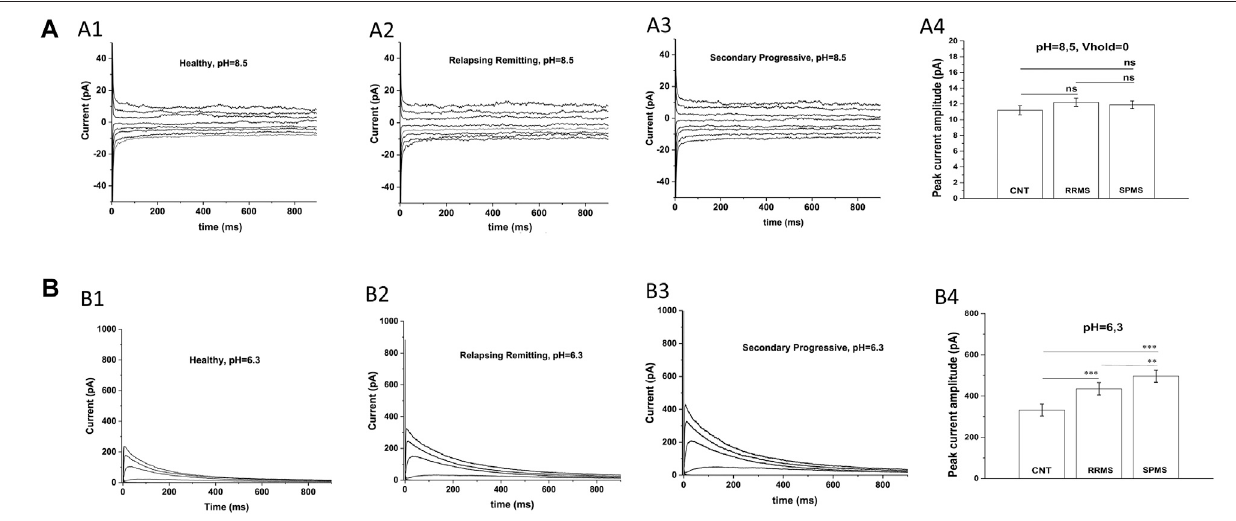
FIGURE 2 | Speci fi c electrophysiological protocols exclude TASK-2 contribution to the increased potassium conductance of MS T lymphocytes. (A) : T cells from eitherMSpatientsorhealthycontrolspresentsimilarcurrent-responsesinalkalinesolutionata0 mVholdingpotential:Whole-cellcurrentsrecordedfromTlymphocytes bathedinanalkaline(pH (cid:1) 8.5)extracellularsolutionwiththeirmembranesclampedat0 mV. (A1 – A3): Whole-cellcurrentresponsesto15 mVvoltage-steps,givenevery 5 s from T lymphocytes of healthy controls, RRMS and SPMS patients. (A4): Average peak currents (at +40 mV) did not differ signi fi cantly between groups. Average values ± SE were: 11.9 ± 0,48 pA for SPMS ( n (cid:1) 12, N (cid:1) 235 cells), 12.2 ± 0,53 pA for RRMS ( n (cid:1) 14, N (cid:1) 282 cells) and 11.2 pA ± 0,6 for healthy subjects ( n (cid:1) 15, N (cid:1) 310 cells) (ns:non-signi fi cant). Method: One way ANOVA with Bonferroni post hoc correction. (B) . T cells ofMS patientsexhibit higher K + currents than controls in acidic extracellular solution: Whole-cell currents recorded from T cells bathed in acidic (pH (cid:1) 6.3) extracellular medium with their membrane held at − 90 mV. K V 1.3 currents from T cells of healthy controls, RRMS and SPMS patients elicited by 1000-ms depolarizing pulses in 15-mV increments, given every 60 s (pH (cid:1) 6.3). (B1 – B3): Displayed are whole-cell K V 1.3 current responses at physiologically relevant potentials, ranging from – 50 mV to +10 mV. T cells from MS patients bathed in acidic extracellular conditions present higher current responses than controls. (B4) : Peak currents at +40 mV were: 496.06 ± 34.5 for SPMS ( n (cid:1) 12, N (cid:1) 230 cells), 435.08 ± 32.1 pA for RRMS ( n (cid:1) 12, N (cid:1) 252 cells) and 332.36 ± 28.9 pA for healthy controls ( n (cid:1) 14, N (cid:1) 310 cells) ( ٭٭٭ : p < 0.001, ٭٭ : p < 0.01, one-way